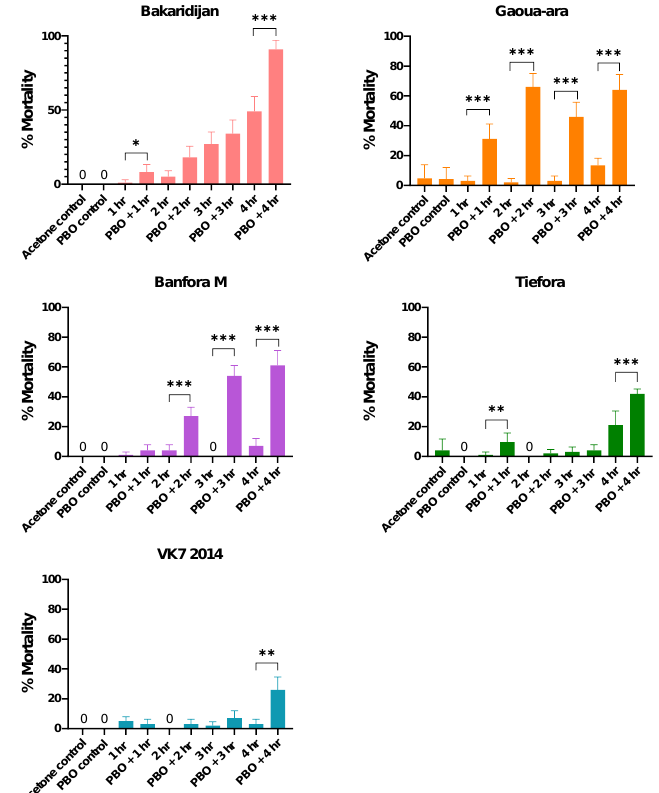
Figure 4. Mortality following exposure to permethrin with or without the synergist PBO. Mortality rates % 24 h after exposure. Minimum sample size n = 80. Error bars represent 95% confidence intervals. Statistical differences between permethrin only and PBO + permethrin for each paired combination indicated as * p <0.05, ** p < 0.001, *** p < 0.001 Fisher’s Exact test. In a separate set of experiments the effect of sequential versus simultaneous exposure to PBO and pyrethroids was compared (Supplementary Figure S1) with pyrethroid expo- sure duration constant at one hour. PBO did not synergise permethrin in these experi- ments but the efficacy of deltamethrin was significantly improved in all three strains with both PBO exposure methods ( p < 0.0001 in all cases). Simultaneous exposure to PBO and pyrethroids results in increased mortalities compared to PBO pre-exposure for all three strains but this was only significant ( p < 0.05) in Bakaridjan for both insecticides and in Banfora with deltamethrin. Full mortality results and synergism ratios are available in additional Supplementary Table S2. 3.3. Cone Bioassays Exposure to the side of the PermaNet 3.0 net in a cone bioassay consistently resulted in <10% mortality for all 5 strains but exposure to the roof (containing PBO) resulted in > 98% mortality (Figure 5).